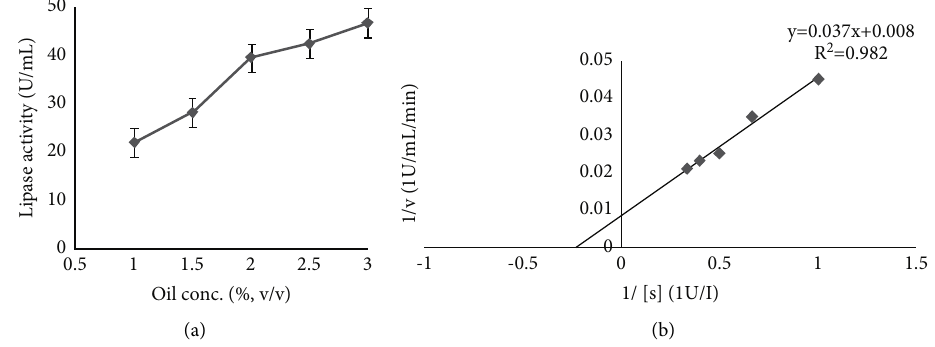
Figure 4: (a) Effect of olive oil concentration on lipase activity. (b) Determination of K